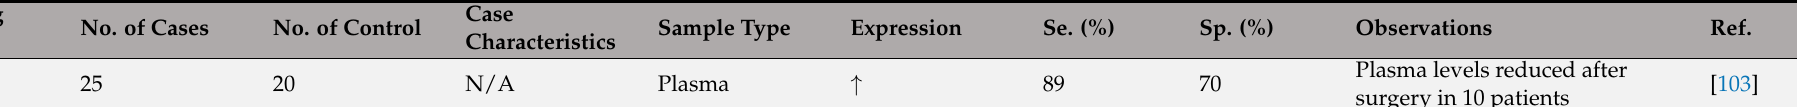
Table 3. Outline on blood circulating microRNAs with confirmed validity in CRC screening and early